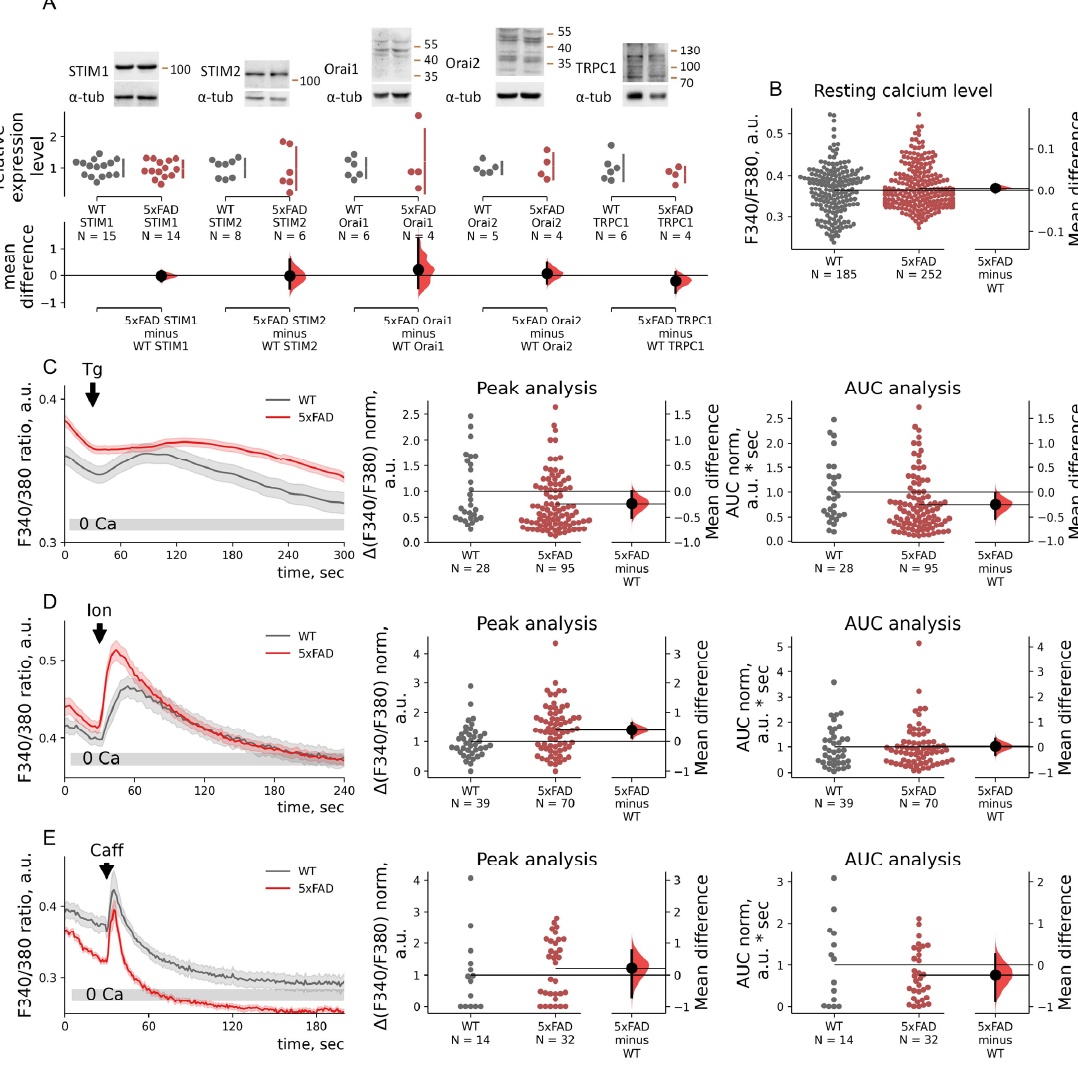
Figure 2 . Intracellular basal calcium concentration or calcium store content and STIM, Orai, and TRPC1 protein expression levels are not affected in 5xFAD hippocampal neurons. ( A ) Western blots with neuronal culture lysates of wild-type (WT) and 5xFAD mice. Relative expression levels were calculated as densitometry of values for the target protein and normalized to α -tubulin val- ues. Data are plotted on the upper axes; WT values were taken as 1; mean differences are plotted on floating axes on the bottom as bootstrap sampling distributions. Normalized data for WT and 5xFAD lysates were compared using unpaired t -test. Mean di ff erences for STIM1 is − 0.03 ( p = 0.74), for STIM2 is ( p = 0.90), for Orai1 is 0.20 ( p = 0.67), for Orai2 is 0.05 ( p = 0.80), and for TRPC1 is − 0.21 ( p = 0.38). ( B ) Resting calcium levels were measured as F340/F380 in neurons in 2Ca aCSF solution before any drugs application. Resting calcium levels in WT and 5xFAD neurons are shown in the estimation plot. Raw F340/F380 data are plotted on the left axes; the mean difference is plotted on floating axes on the right as a bootstrap sampling distribution. The mean difference between basal calcium entry of WT and 5xFAD neurons is 0.006; p = 0.75, Mann–Whitney test. ( C – E ) Calcium imaging with Fura2 of neurons of primary hippocampal cultures of wild-type (WT, gray) or 5xFAD (red) mice. Mean traces of F340/380 ratio are represented as mean ± SEM. Areas under the curve (AUC) are for response peaks after stimulation Ca 2+ release. Δ F340/F380 and AUC values are nor-